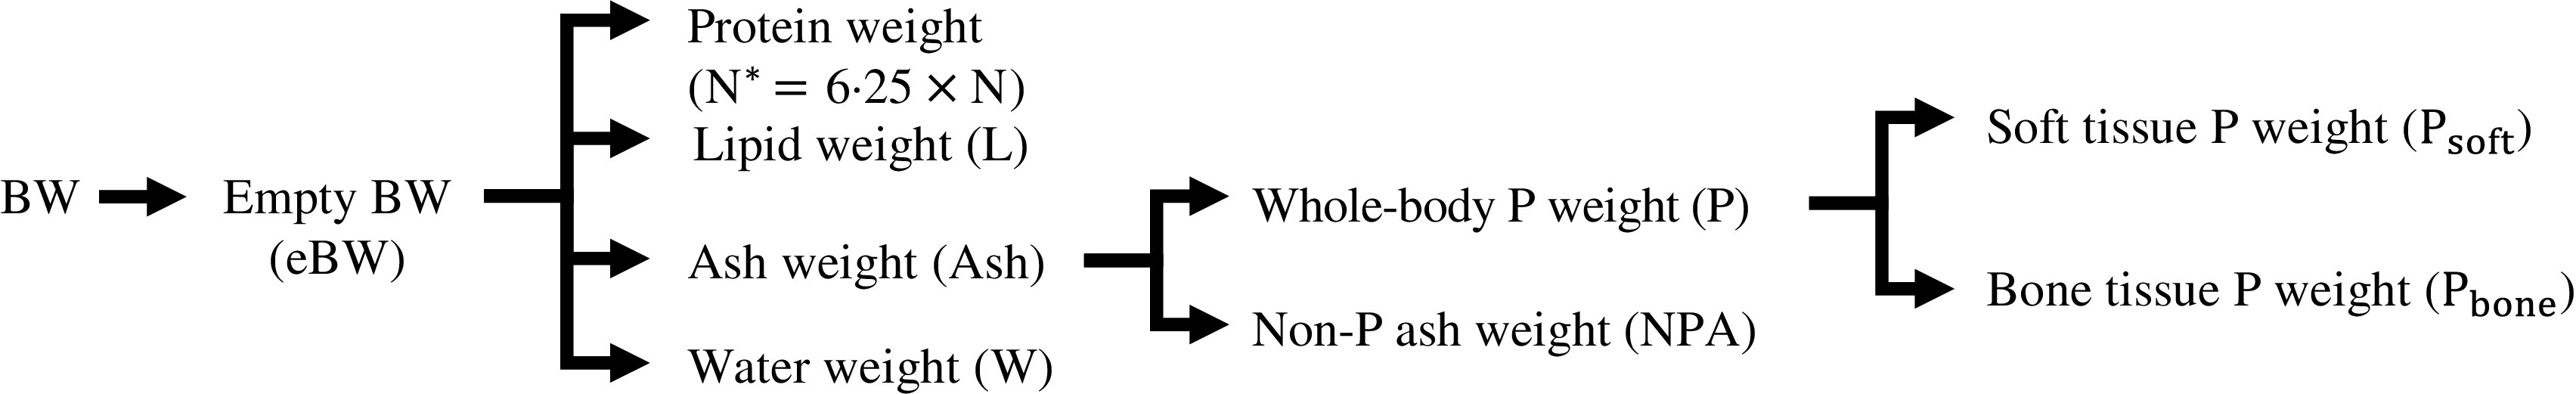
Basic animal description, demonstrating the partitioning of live body weight (BW) into the main body components of growing and finishing pigs.